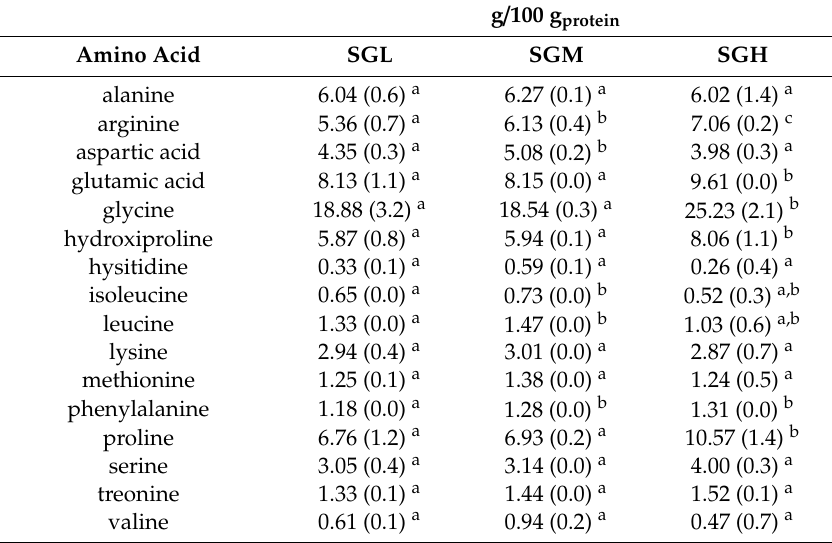
Table 3. Amino acidic profile (g / 100 g protein ) of SG with controlled molecular weight. Values in brackets correspond to standard deviation (n = 3). Within the same row, di ff erent superscript lowercase letters show significant di ff erence ( p < 0.05).